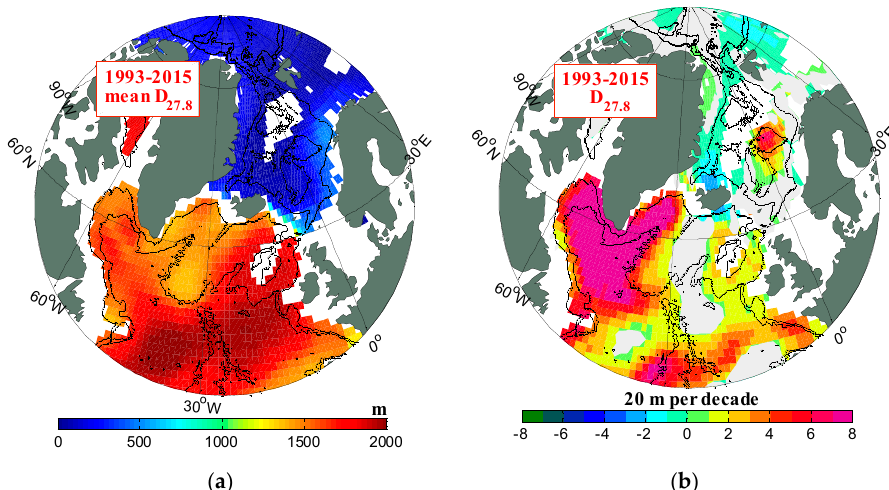
Figure 5. The spatial distribution of the mean value ( a ) and change rate ( b ) of D 27.8 from 1993 to 2015. The D 27.8 is the depth of σө = 27.8 kg/m 3 .